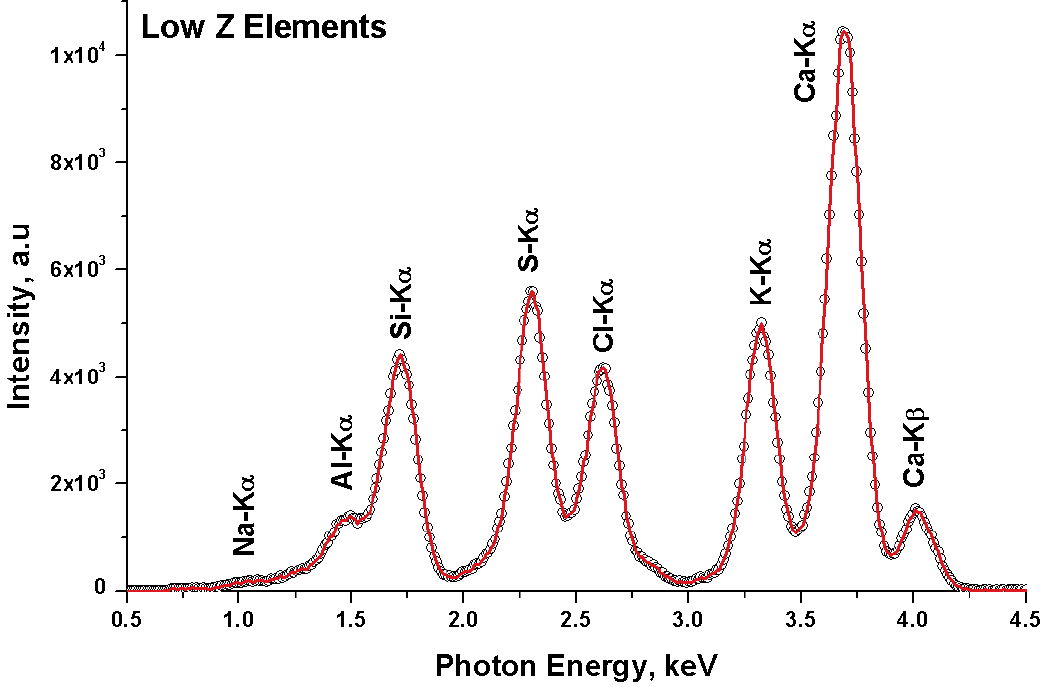
Figure 5. The EDXRF spectrum of the low Z elements using CaF 2 secondary target for selected PM 2.5 sample from historical Jeddah district, Saudi